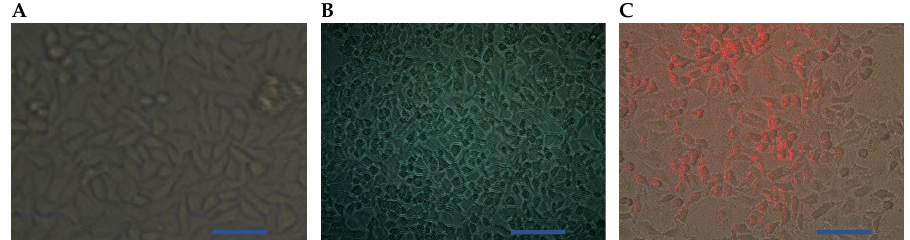
Figure 5. Representative photomicrographs ( A ) Control untreated cells ( B ) Cells treated with 3 µg/mL of C-TPP NPs, ( C ) Optical tomography (using NIR laser) for the treated cells (3 µg of C-TPP NPs), Scale bar 20 µm.